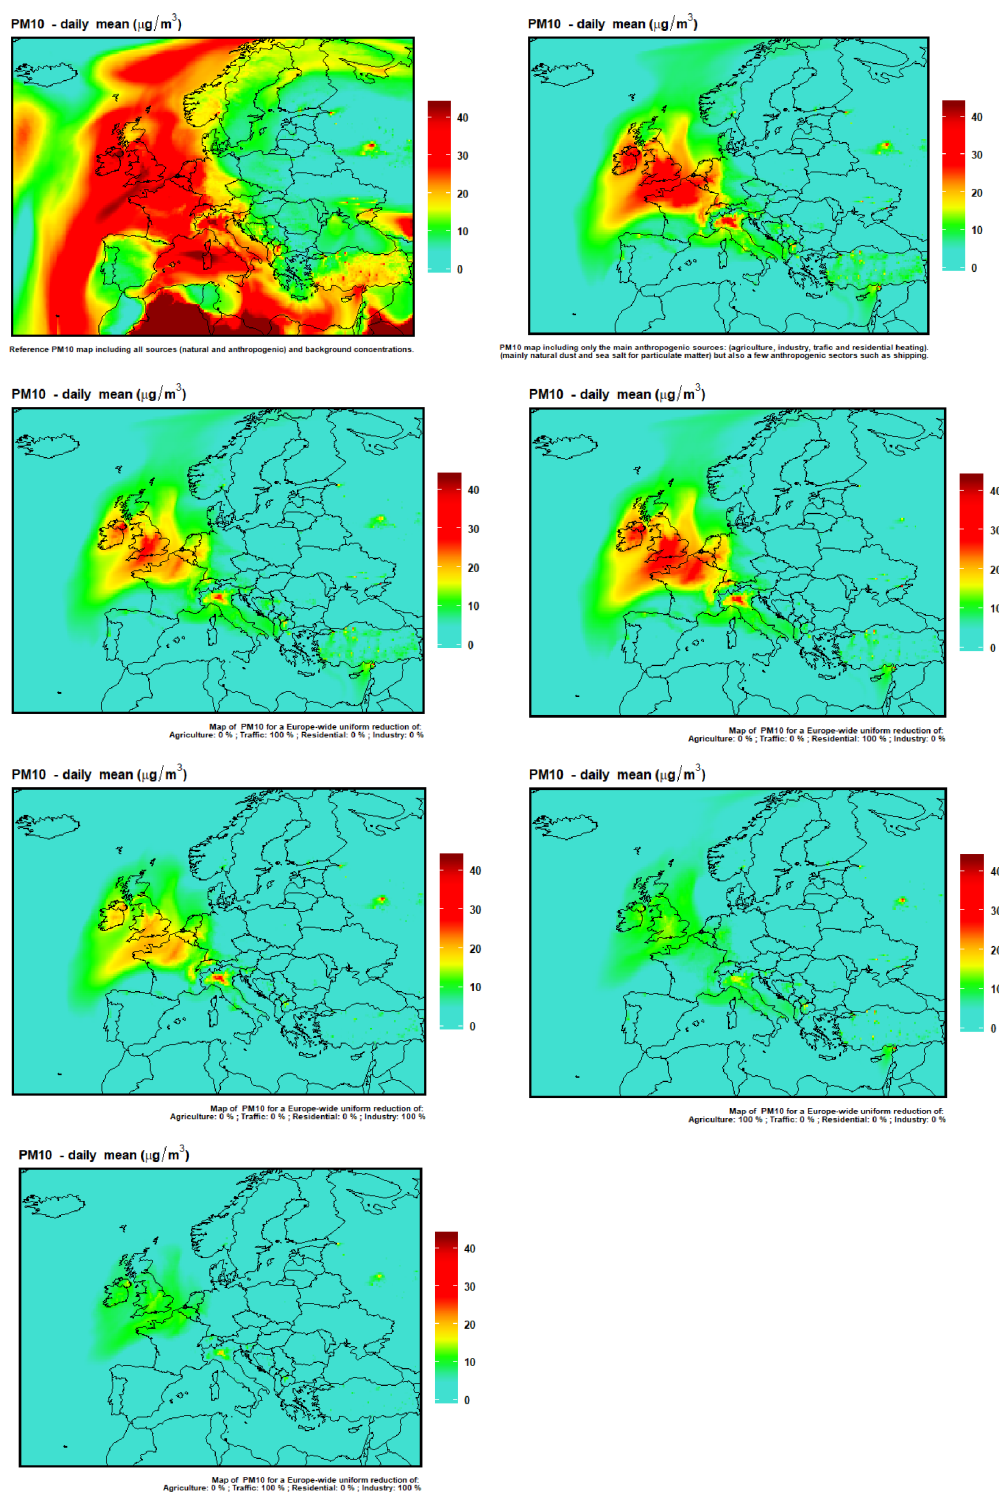
Figure 12. First row: PM 10 concentrations on 18 March 2015 including (left) or excluding (right) natural and background concentrations. Following rows: PM 10 daily average concentrations emulated with ACT for 18 March 2015 for a 100% reduction of traffic emissions (second row, left), residential emissions (second row, right), industry emissions (third row, left), agriculture emissions (third row, right) and both traffic and industry (fourth row,